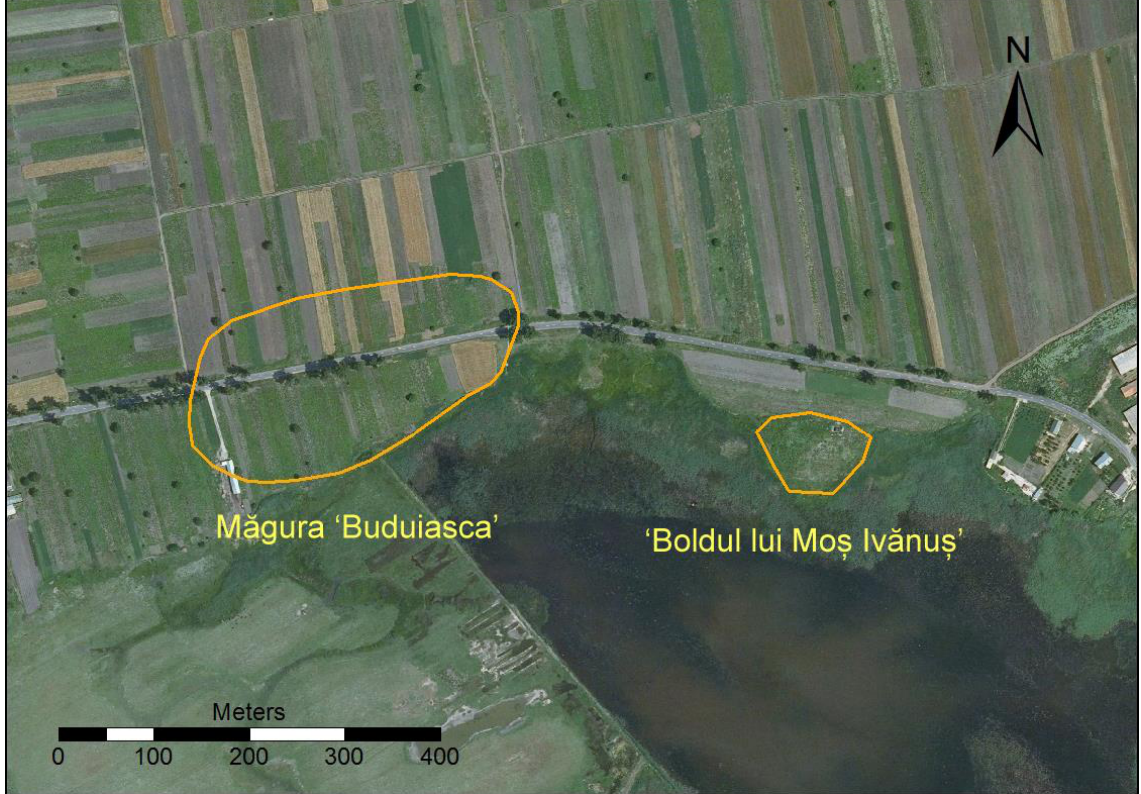
Figure 2. Aerial photograph showing the location of the the Măgura ‘Buduiasca’ site and the ‘Boldul lui Moş Ivănuş’ component. (Aerial photo from the ANCPI orthophoto